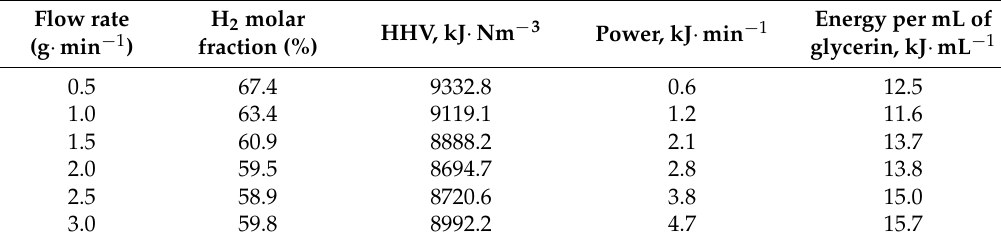
Table 2. Characteristic parameters of glycerin steam gasification. Effect of water/glycerin flow rate. Water/glycerin ratio (9/1); Temperature 900 °C; HHV: highest heating value.